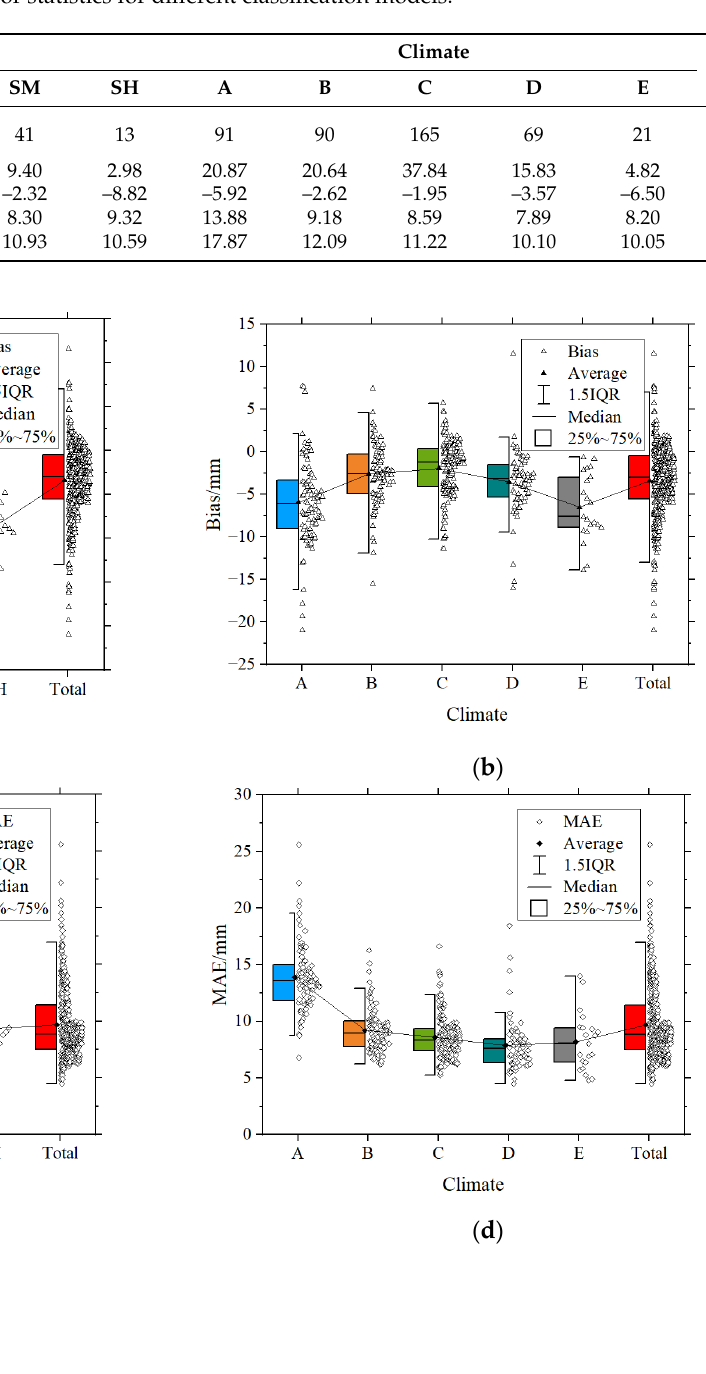
Table 5. ERA5 error statistics for different classification models.